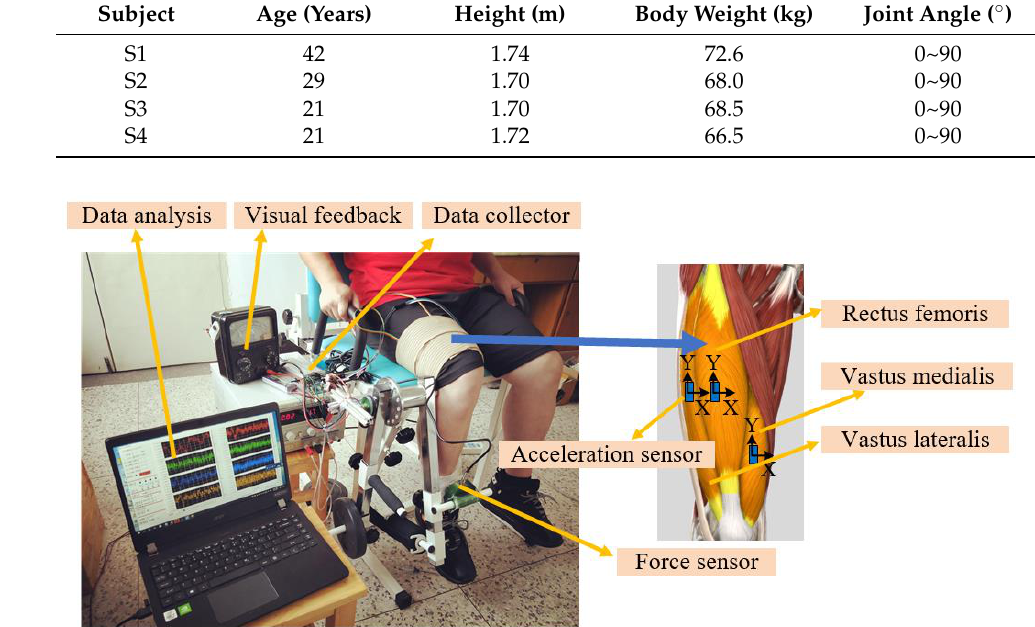
Figure 3. Experimental setup and the acceleration sensor location.